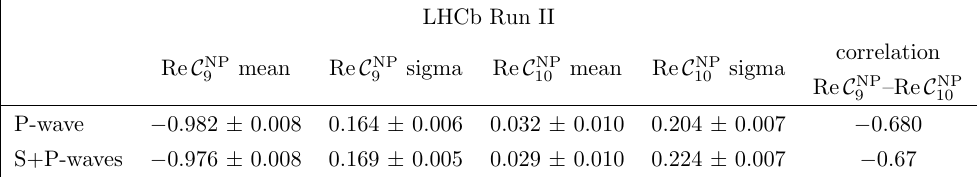
Table 7 . Fit results obtained when (cid:13)oating C NP the BMP scenario with the corresponding statistics expected at the LHCb Run